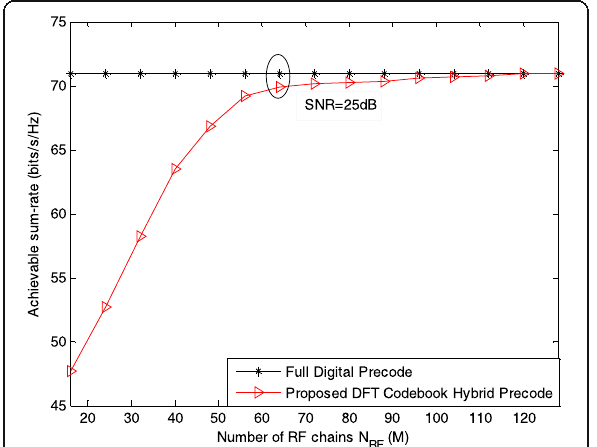
Fig. 8 The energy efficiency vs. SNR ( N BS = 128 and U =